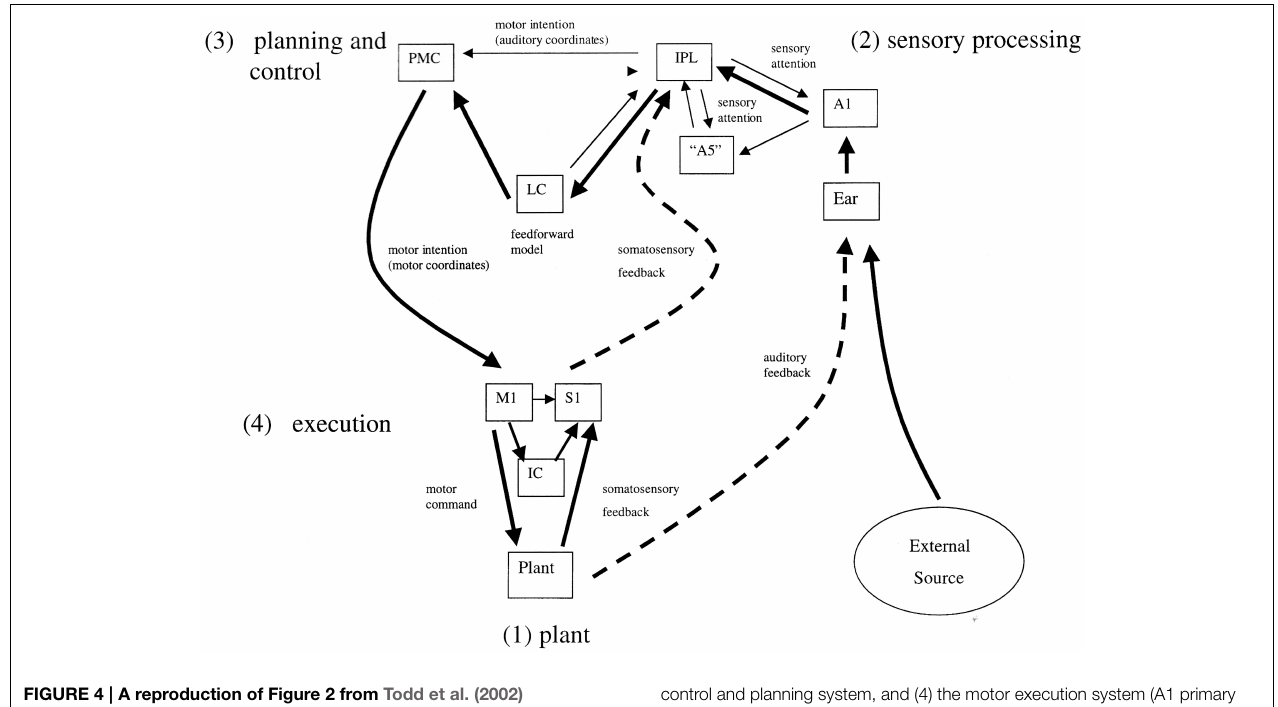
control and planning system, and (4) the motor execution system (A1 primary auditory cortex, “A5” secondary auditory cortex; IPL, inferior parietal lobule;